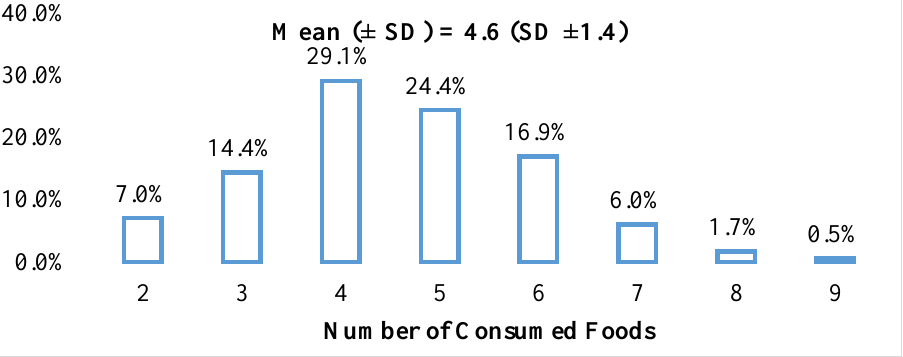
Figure 2. Food consumption pattern of Khmer minority households by the number of foods consumed (%).